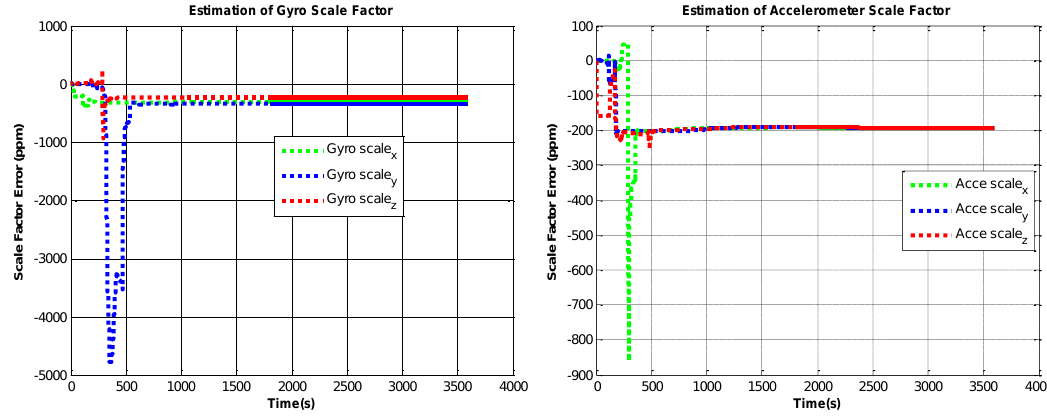
Figure 7. Estimation curves of gyroscope and accelerometer scale factor